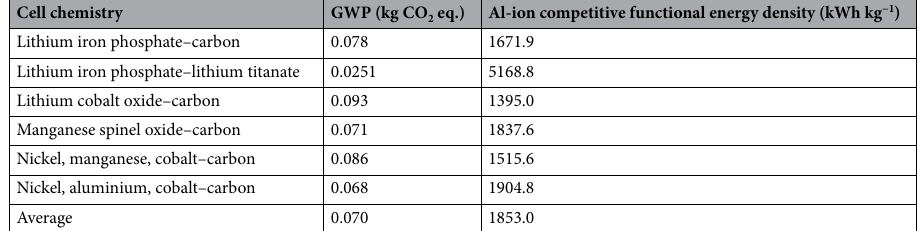
Table 2. Averaged competitive functional energy density for a variety of Li-ion chemistries—values taken from (Peters et al. 7 ).